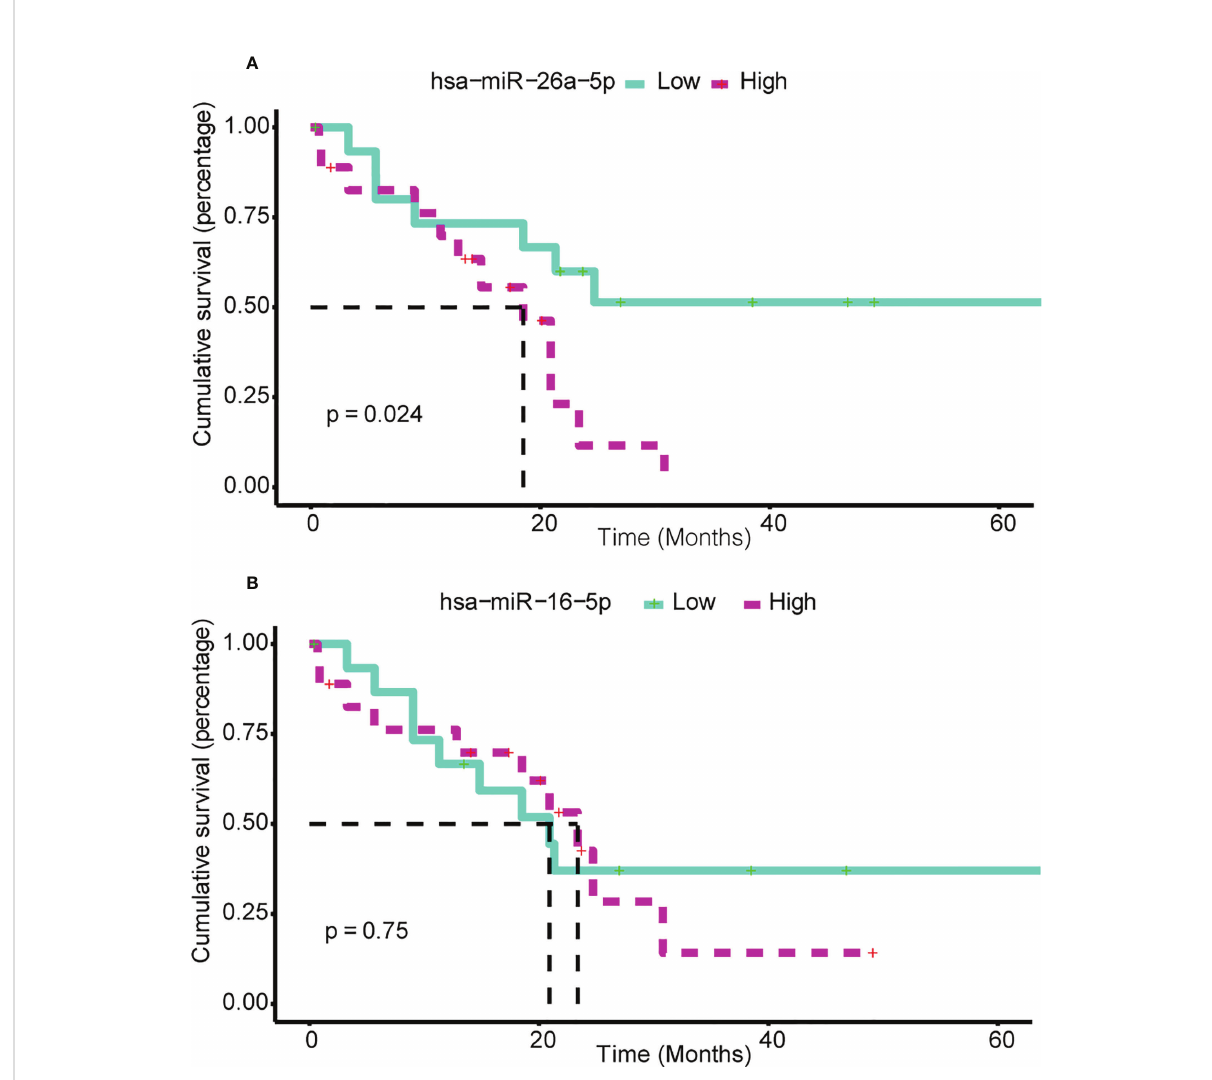
FIGURE 6 Ser-miRNA was associated with BTC prognosis. (A) hsa-miR-26a-5p and (B) hsa-miR-16-5p Predict Survival in BTC. The green (red) color bar represents low-express (high-express) patient groups. Kaplan – Meier estimates of 3-year survival of BTC patients in